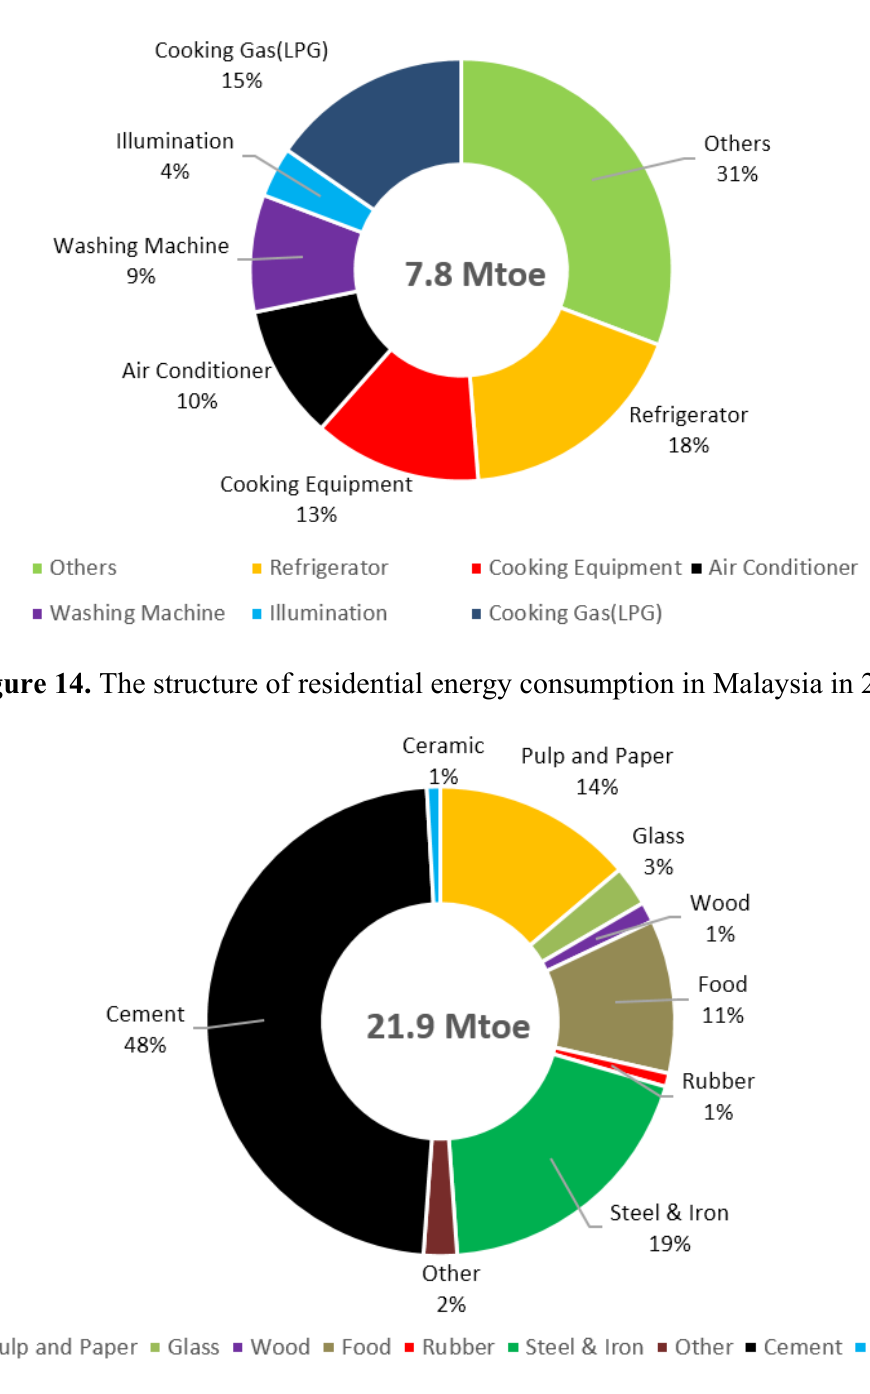
Figure 15. Industrial sector energy consumption in Malaysia in